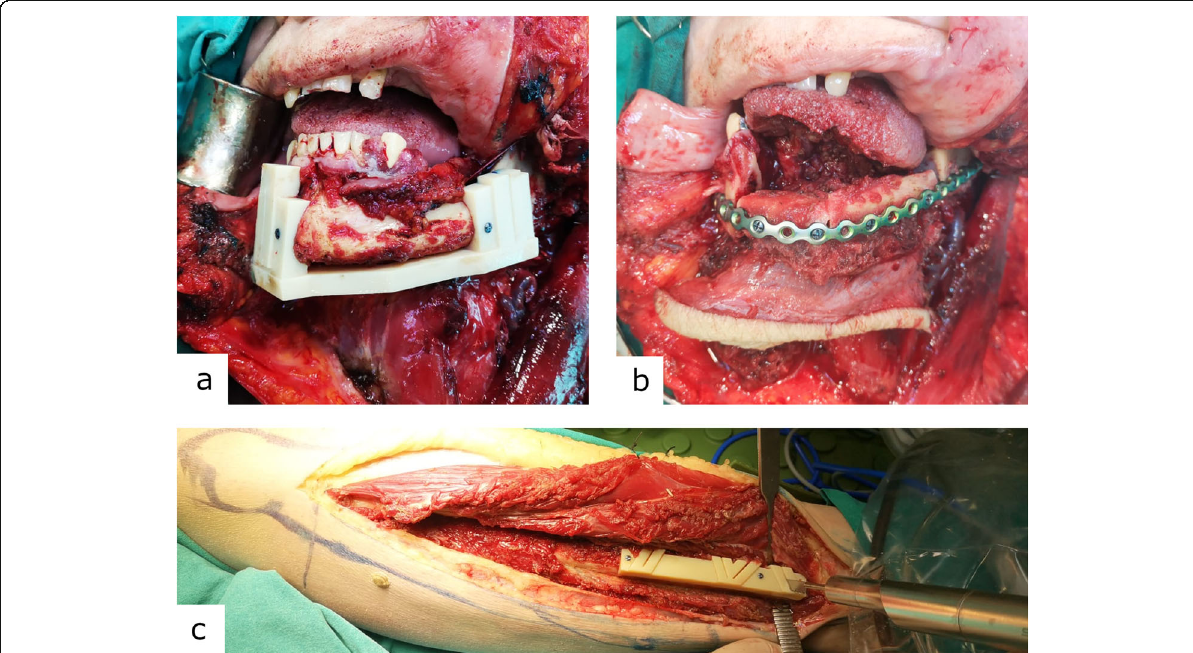
Fig. 4 a Properly positioned and perfectly fitting three-dimensional printed cutting guide for mandible osteotomy. b Well-positioned bony grafts fixed with pre-shaped reconstruction plate. c Properly positioned three-dimensional printed personalised cutting guide for fibula